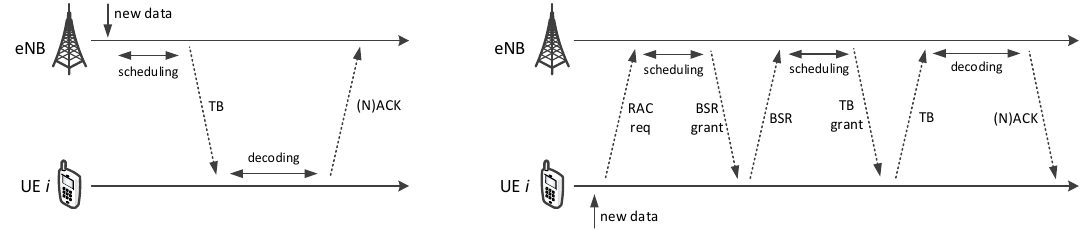
Figure 2. Procedures for DL ( left ) and UL ( right ) data transmissions.